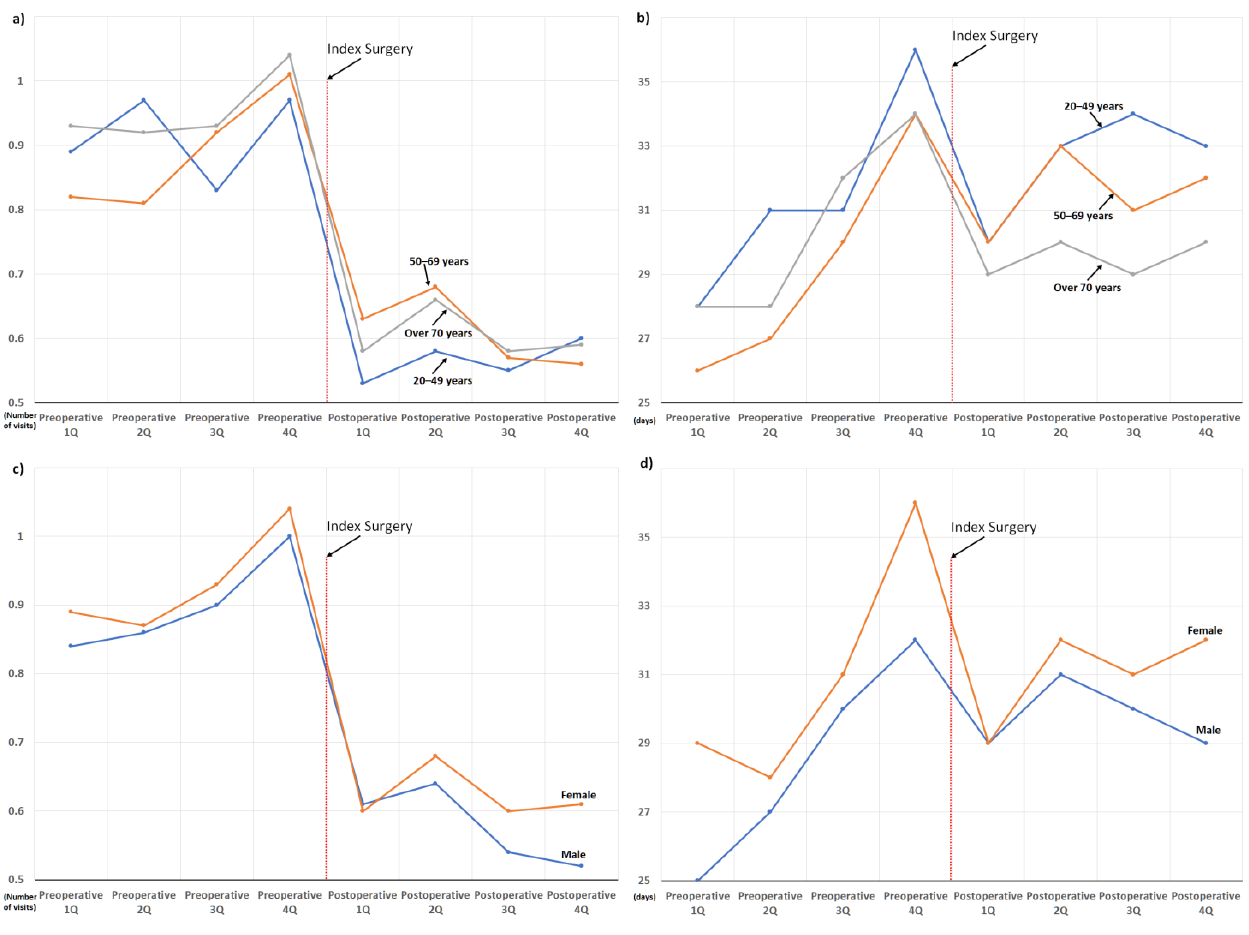
Figure 5. Perioperative changes in the use of sleep medication and hospital visits owing to sleep disorder according to the demographics: ( a ) changes in the number of hospital visits according to the age groups; ( b ) changes in the prescribed duration of sleep medication according to the age groups; ( c ) changes in the number of hospital visits according to sex groups; and ( d ) changes in the prescribed duration of sleep medication according to sex groups.